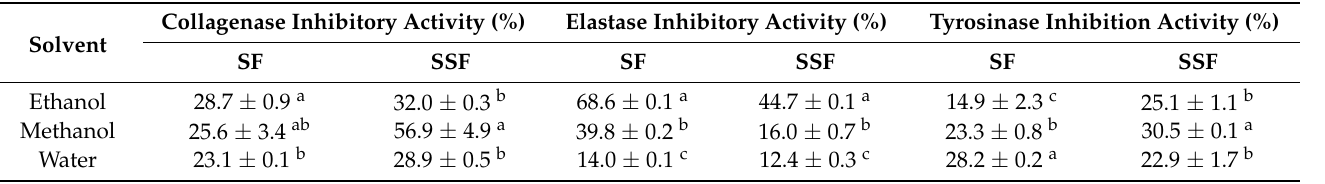
Table 3. Collagenase, elastase, and tyrosinase inhibitory activities of fresh and steamed Sargassum fusiforme